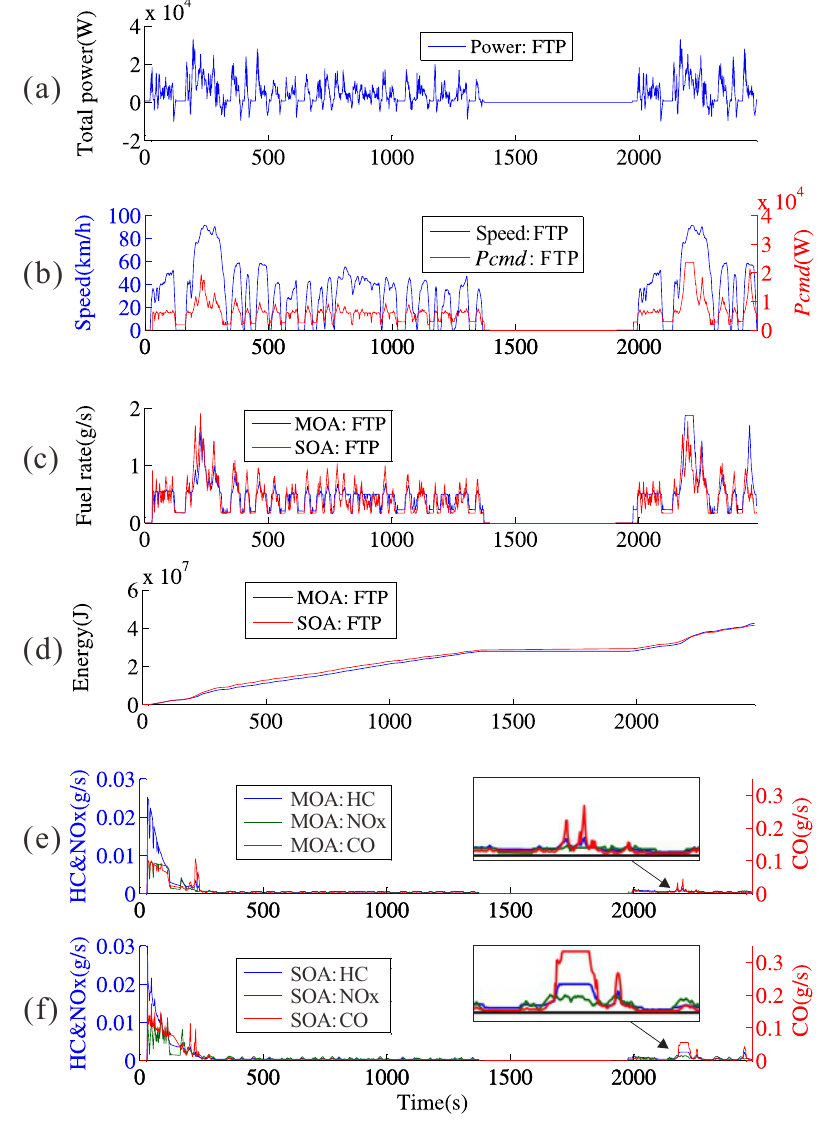
Figure 10. Required total power, speed, power, fuel rate, cumulative energy consumption and emissions of the Federal test procedure (FTP) driving cycle. ( a ) total power; ( b ) speed and power; ( c ) fuel rate; ( d ) cumulative energy consumption; ( e ) emissions from MOA; and ( f ) emissions from